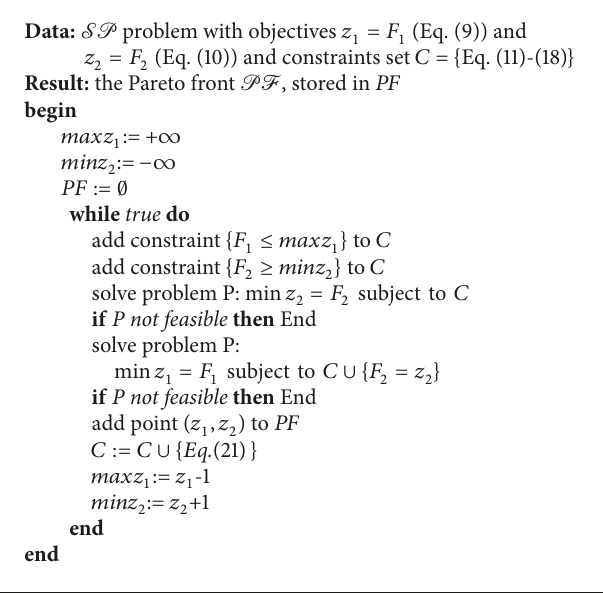
Algorithm 1: An 𝜖 -constraint based method for solving SP (with cumulative distance).